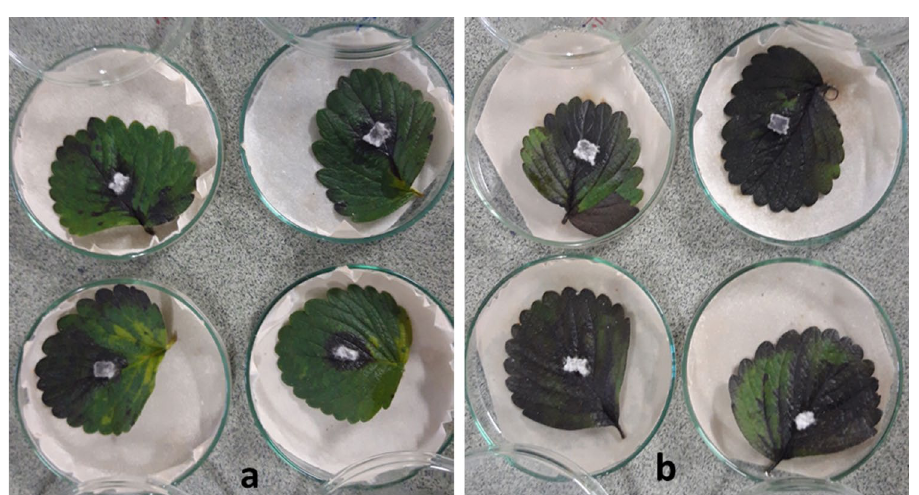
Figure 5. Necrosis symptoms on strawberry leave (Camarosa) 7 dpi by N. parvum . ( a ) Leaves transiently expressed pFGC-TEF-d as a treatment and ( b ) control leaves expressing empty plasmid ( pFGC 5941).